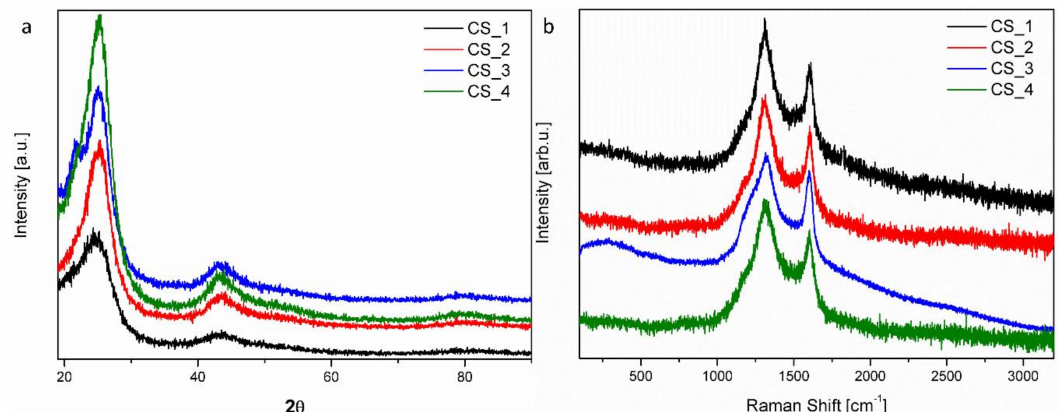
Figure 4. X-ray diffraction (XRD) patterns ( a ) and Raman spectra ( b ) of carbon spheres with different times of synthesis.